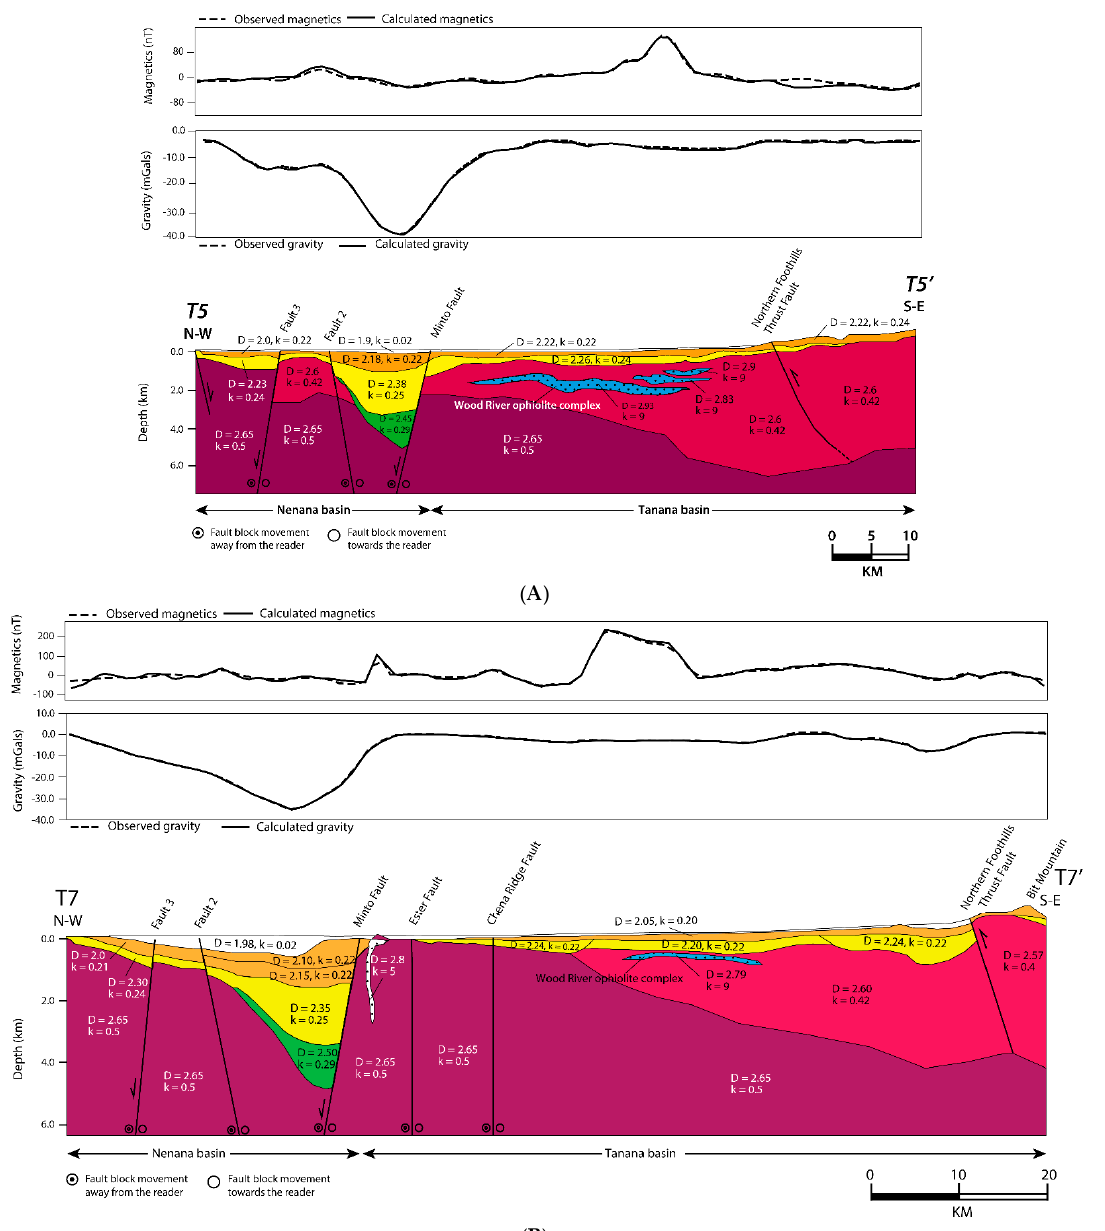
Figure 10. A total of 2 ½ gravity and magnetic models across the Tanana basin. ( A ) Model T5 is oriented NW–SE across the southern part of the Nenana basin. ( B ) Model T7 strikes NW–SE across the northern part of the Nenana basin. The profile locations are shown in Figure 3. The upper panels show observed (dotted black line) and calculated (solid black line) gravity and magnetic anomaly curves. The lower panel shows the potential field model with individual source bodies colored by lithology and labeled with density (× 10 3 kg/m 3 ) and magnetic susceptibility (× 10 3 SI). Blue dotted line shows the limit of seismic reflection data in our study area. Table 1 summarizes measured average magnetic susceptibility and rock density values for modeled lithologic units in our study area.